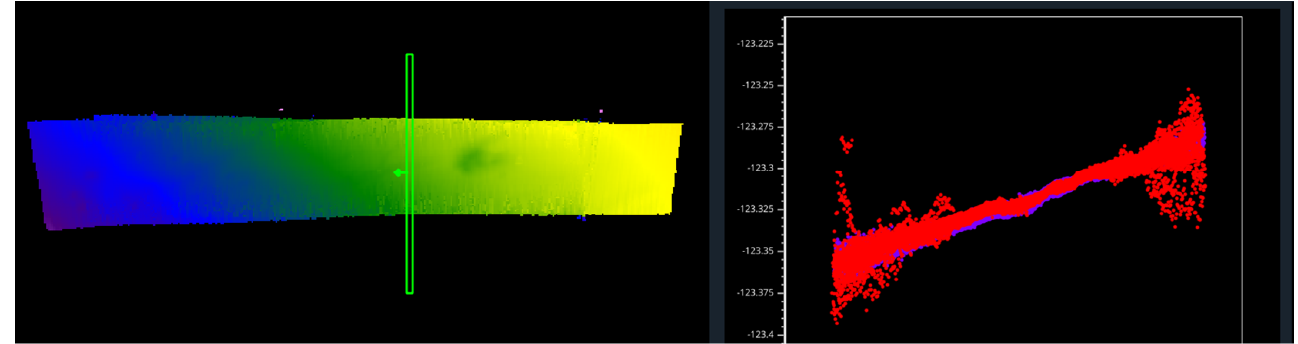
Figure 7. Latency Test shown in the Advanced Plots tool.